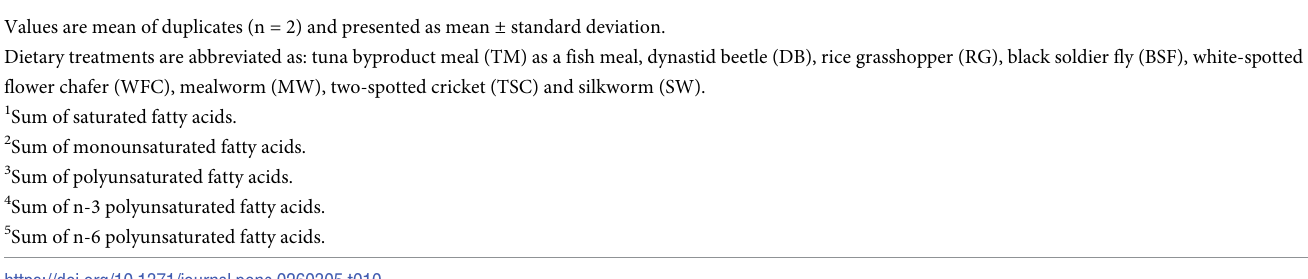
Values are mean of duplicates (n = 2) and presented as mean ± standard deviation. Dietary treatments are abbreviated as: tuna byproduct meal (TM) as a fish meal, dynastid beetle (DB), rice grasshopper (RG), black soldier fly (BSF), white-spotted flower chafer (WFC), mealworm (MW), two-spotted cricket (TSC) and silkworm (SW). 1 Sum of saturated fatty acids.